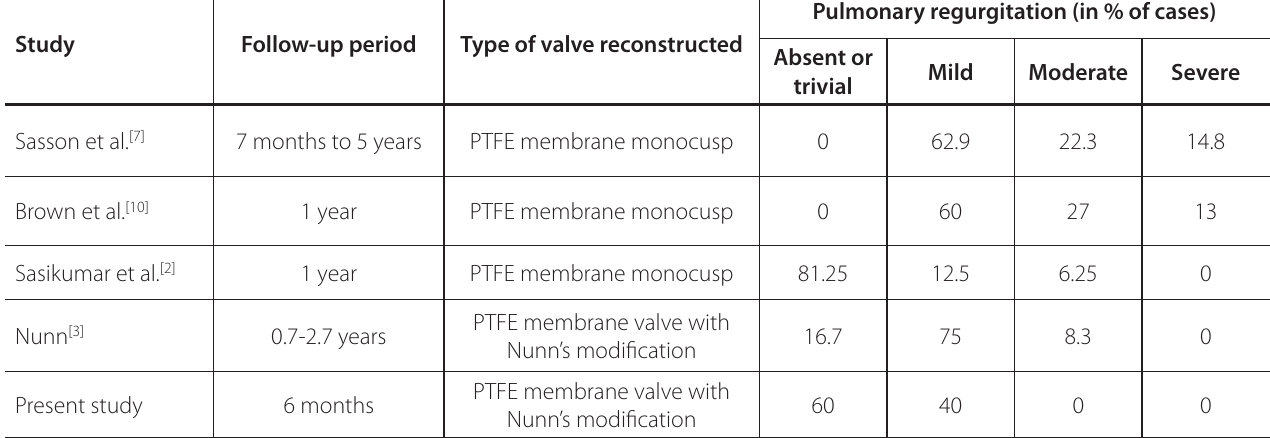
Table 8 . Other studies versus the present study comparing severity of pulmonary regurgitation at the end of the follow-up period.